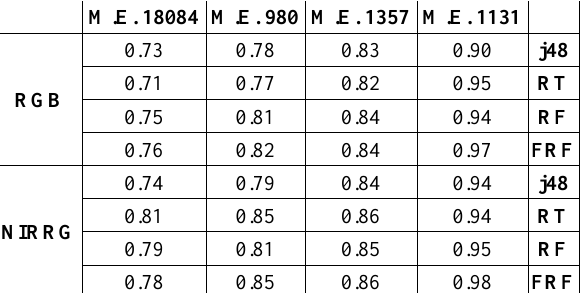
Table 1. Accuracy results for different